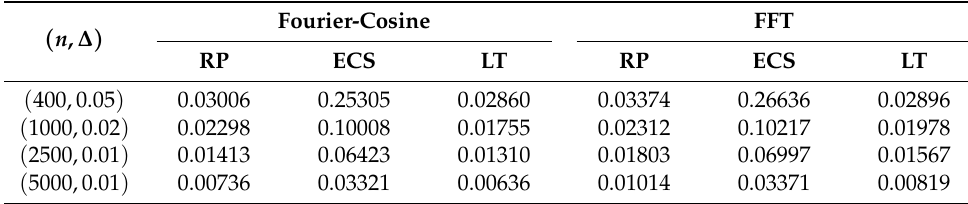
Table 2. In the Lévy-Gamma risk model, IMSEs for (cid:98) φ ( u ) . ( n , ∆